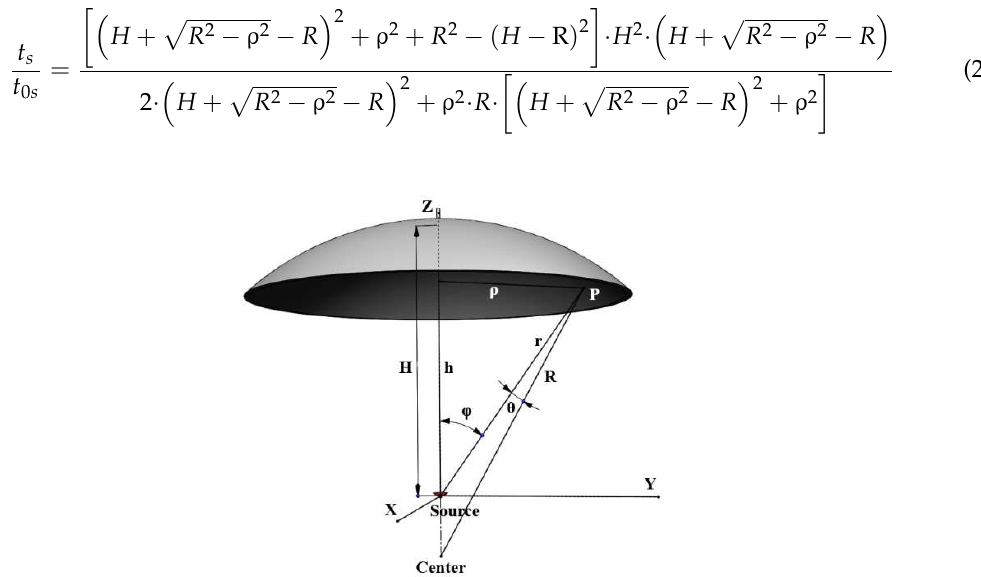
Figure 8. Spherical surface substrate holder, where H is the distance between the source and the top of the substrate holder, h is the height of sample to the source position, φ is the angle between the normal of the source and the line connecting the source to the P point; θ is the angle between the normal of the substrate and the line connecting the source to the P point; ρ is the distance from the center of the substrate holder to the P point; r is the distance from the source to the P point; P is any point on the substrate holder. R is the diameter of the spherical dome.